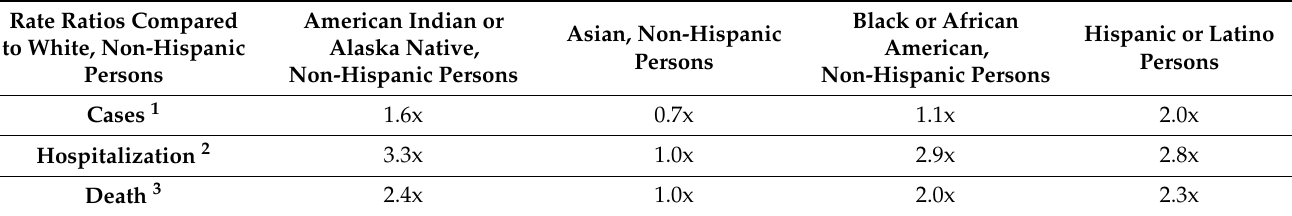
Figure 1. Disproportionate coronavirus disease 2019 (COVID-19) mortality rates. AIAN: American Indian and Alaska Native; NHOPI: Native Hawaiian and Other Pacific Islanders. Similarly, recent data from the Centers for Disease Control and Prevention (CDC) demonstrate a consistent pattern of racial/ethnic differences in the risk for COVID-19 in- fection, hospitalization, and death (Table 1) [5–7]. Table 1. Risk for COVID-19 infection, hospitalization, and death by race/ethnicity.